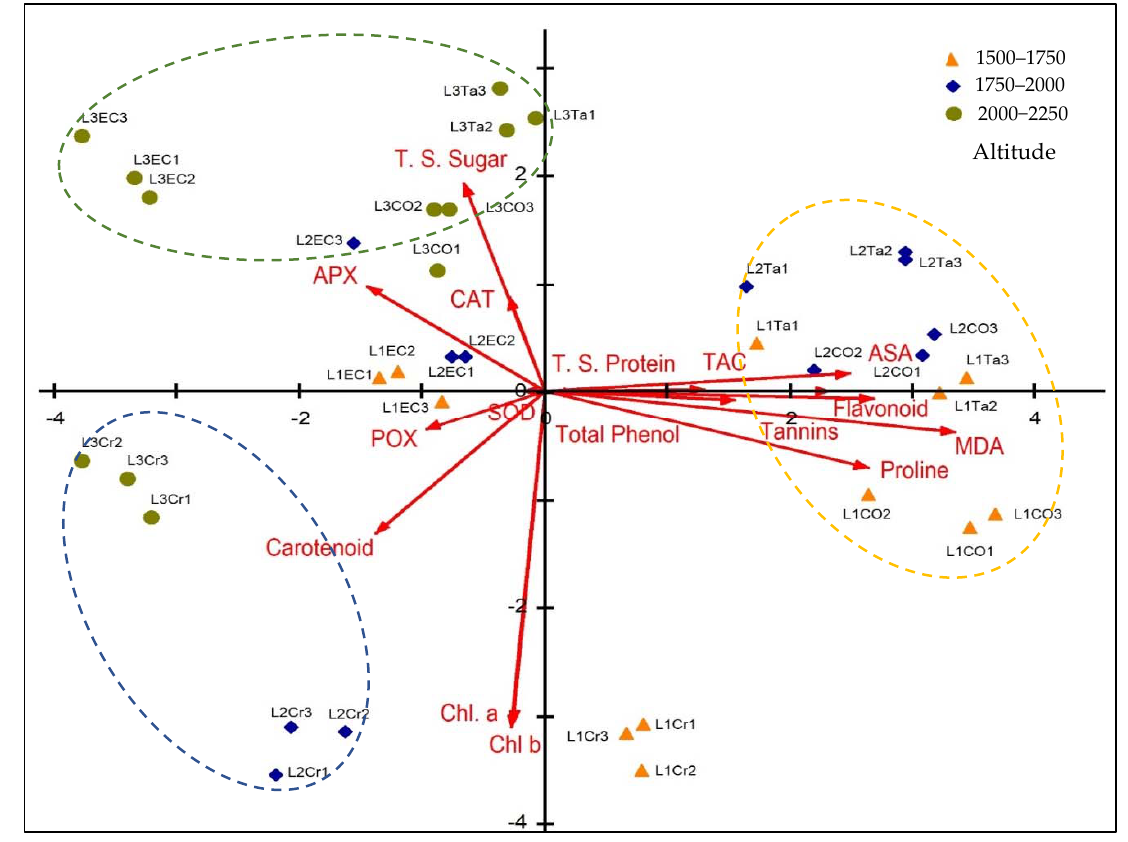
Figure 8. PCA joint plot showing target species at different altitudes in relation to physiological parameters. Abbreviations: L1 = altitude 1; L2 = altitude 2; L3 = altitude 3; Co . = Cotineaster orbicularis ; Cr. = Crataegus sinaica; Ec. = Echinops spinossissmus; Ta. = Tanacetum sinaicum.